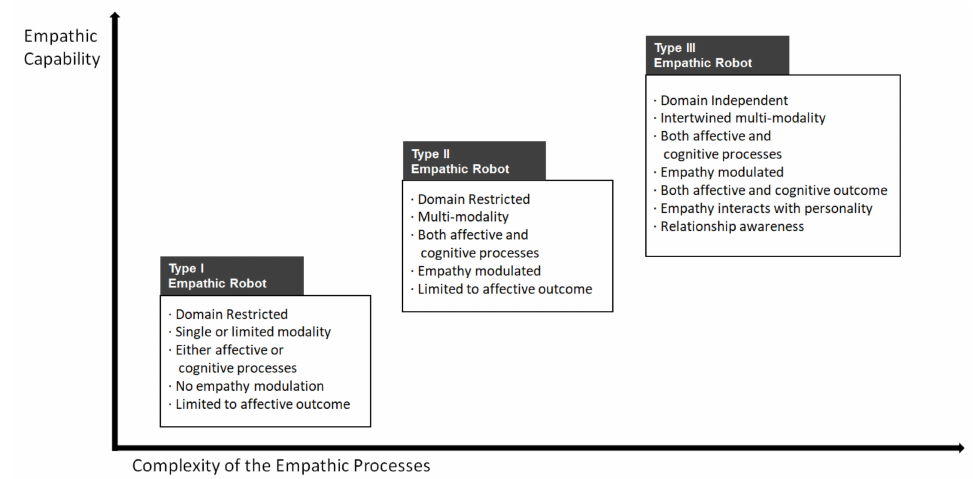
Figure 2. Empathic capability as a function of the complexity of empathic